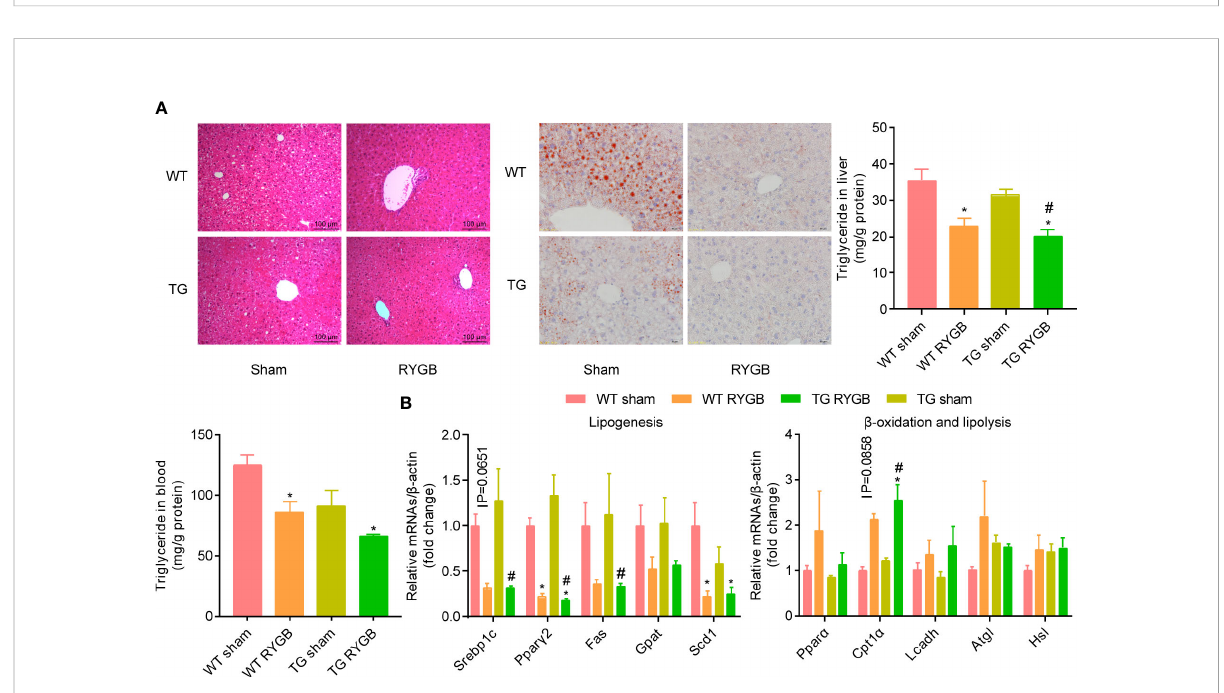
FIGURE 5 Effect of RYGB on liver steatosis in TG mice with lower ghrelin levels Validated TG mice and wild-type littermates (WT) were fed with high fat diet (HFD) for 12 weeks before surgery and 3 weeks after surgery. Results were expressed as mean ± SEM. P values were determined by one/two-way ANOVA, followed by Tukey multiple post hoc analysis. *P<0.05 vs. WT Sham. # P<0.05 vs. TG Sham. n=4-6 mice per group. (A) Liver histology (H&E), Oil red staining, hepatic and plasmic contents of triglyceride. (B) mRNA levels of hepatic lipogenesis, b -oxidation and lipolysis marker